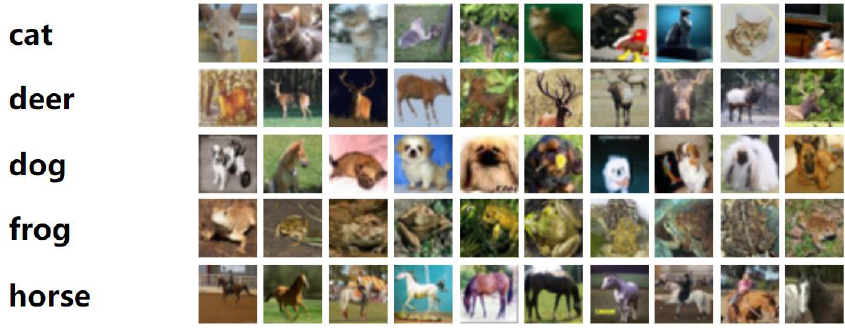
Figure 5. Examples of CIFAR100 open dataset.